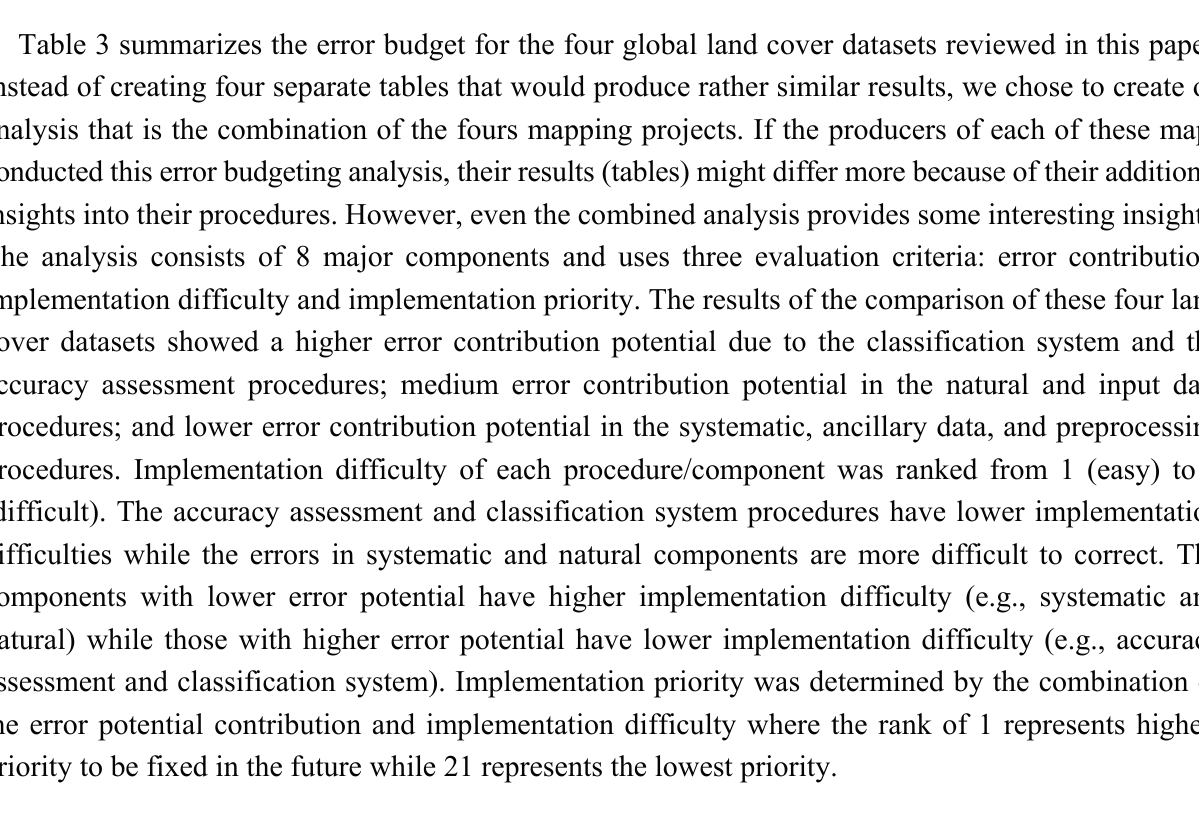
Table 3. Error Budget for the global land cover mapping